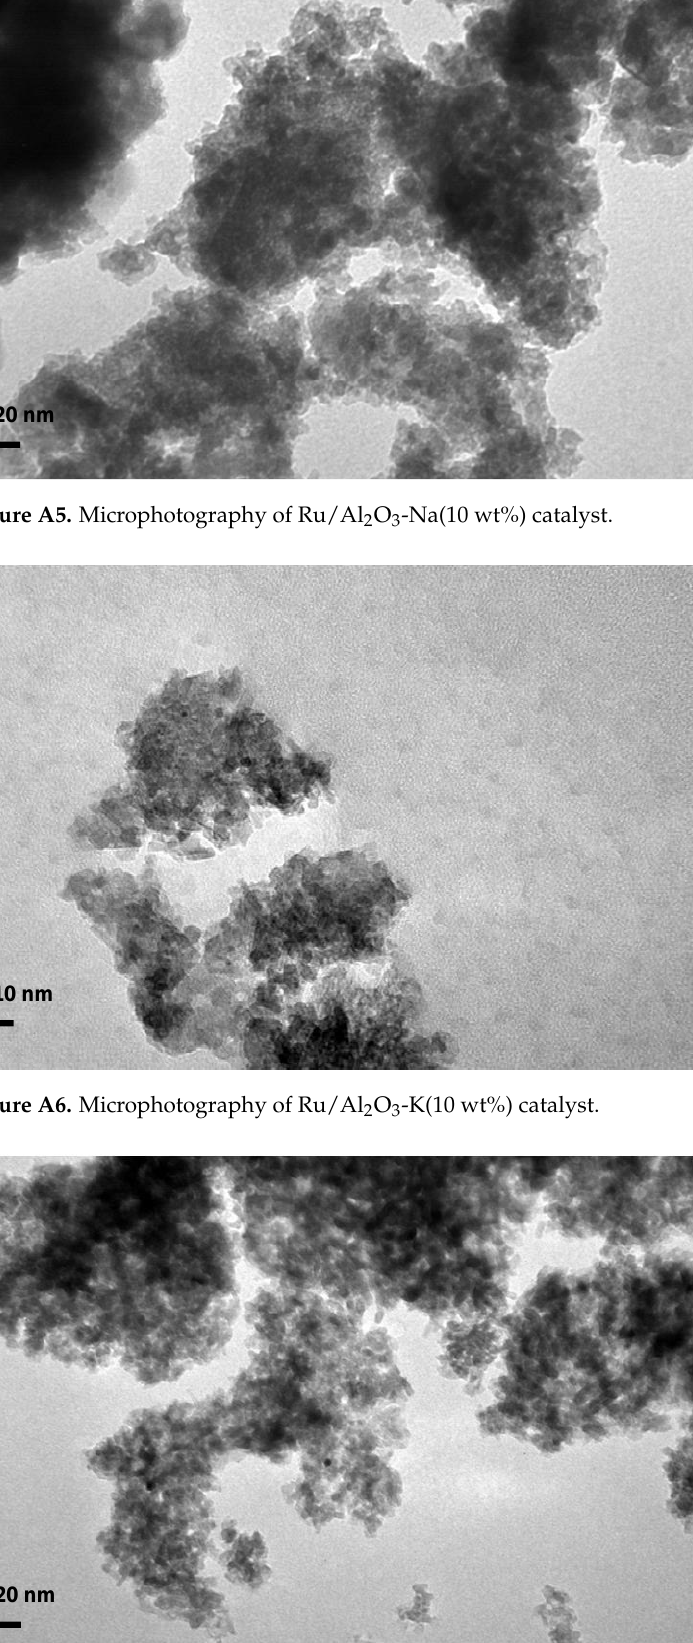
Figure A7. Microphotography of Ru/Al 2 O 3 -Ba(10 wt%) catalyst.